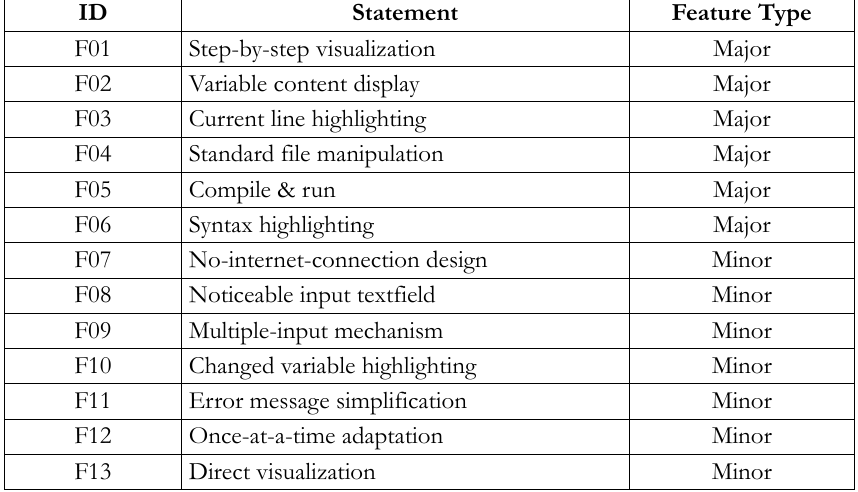
Table 4. The 2 nd survey: involved